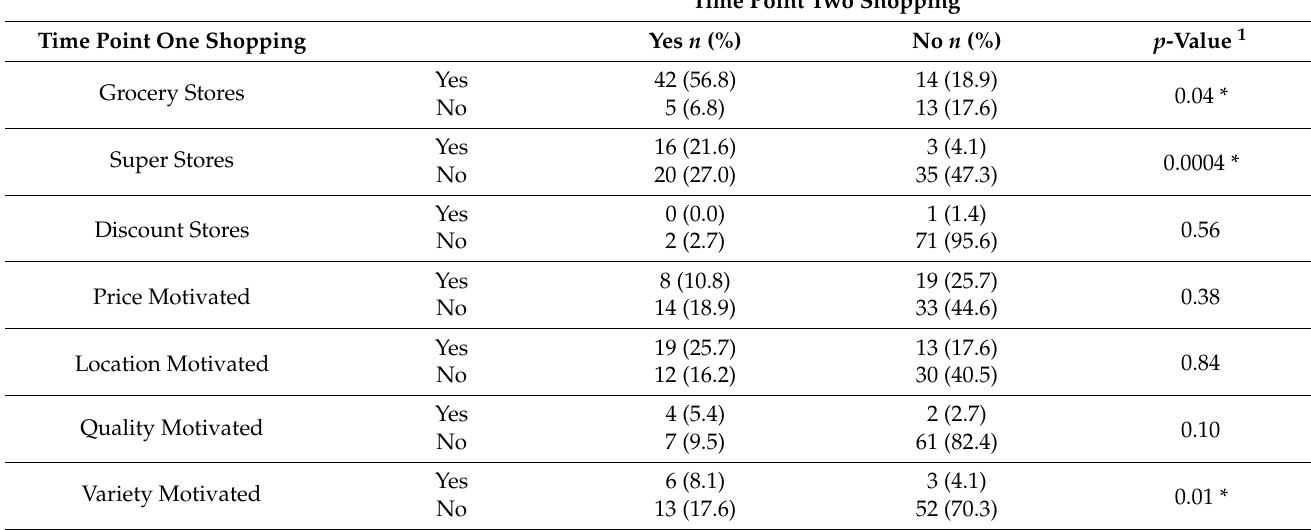
Table 2. Grocery shopping habits and changes from time point one to time point two among cohort participants. Time Point Two Shopping